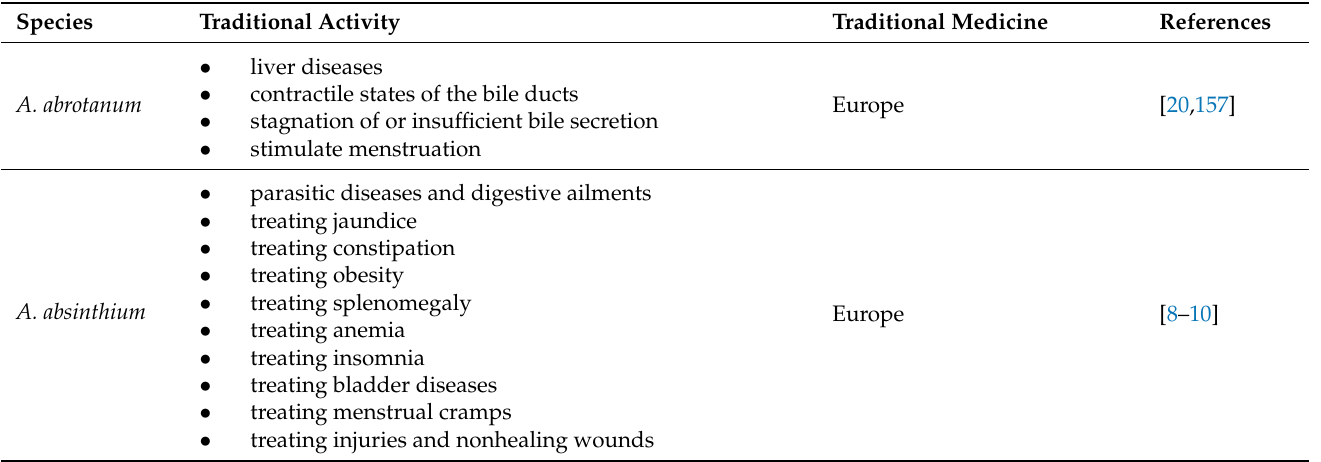
Table 4. Ethnopharmacological uses of Artemisia